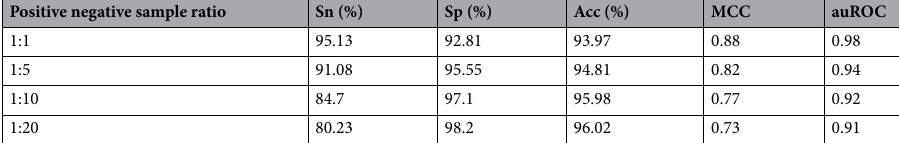
Table 6. 5 fold cross validation performance of i6mA-CNN model when trained with disproportionate number of positive and negative samples.